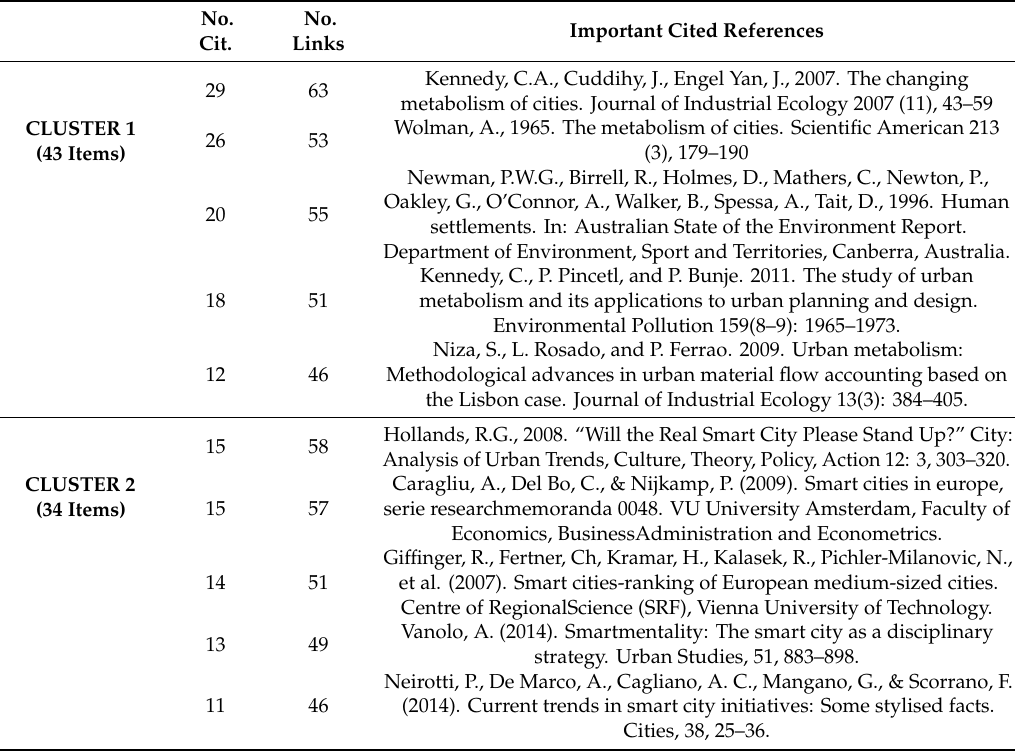
Figure 7. Map of co-citation analysis based on cited references. Table 6. Important cited references under co-citation links per infometric